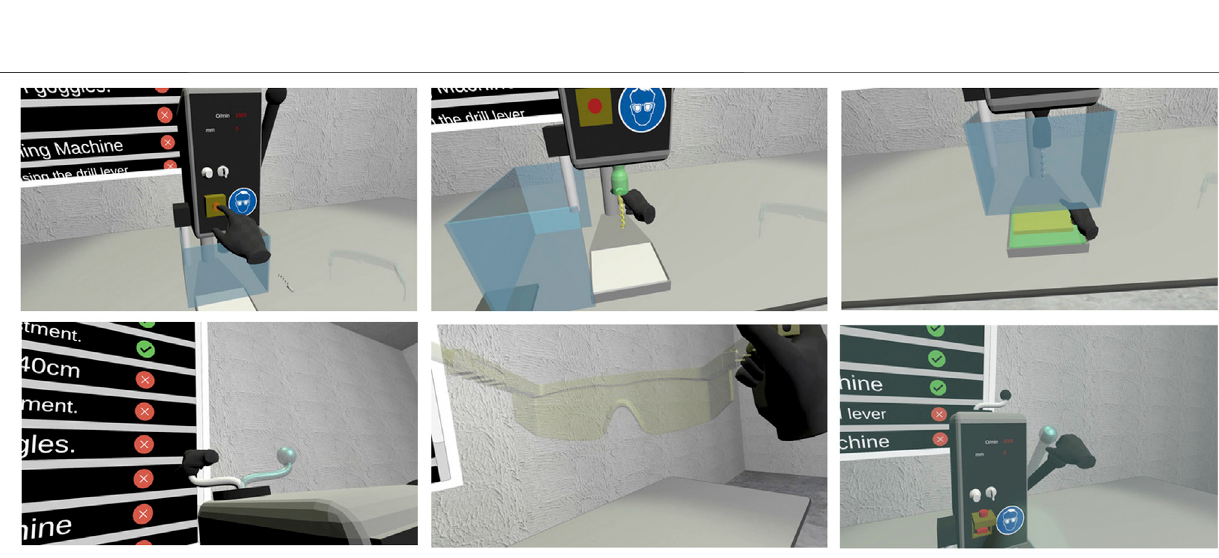
Frontiers in Virtual Reality |